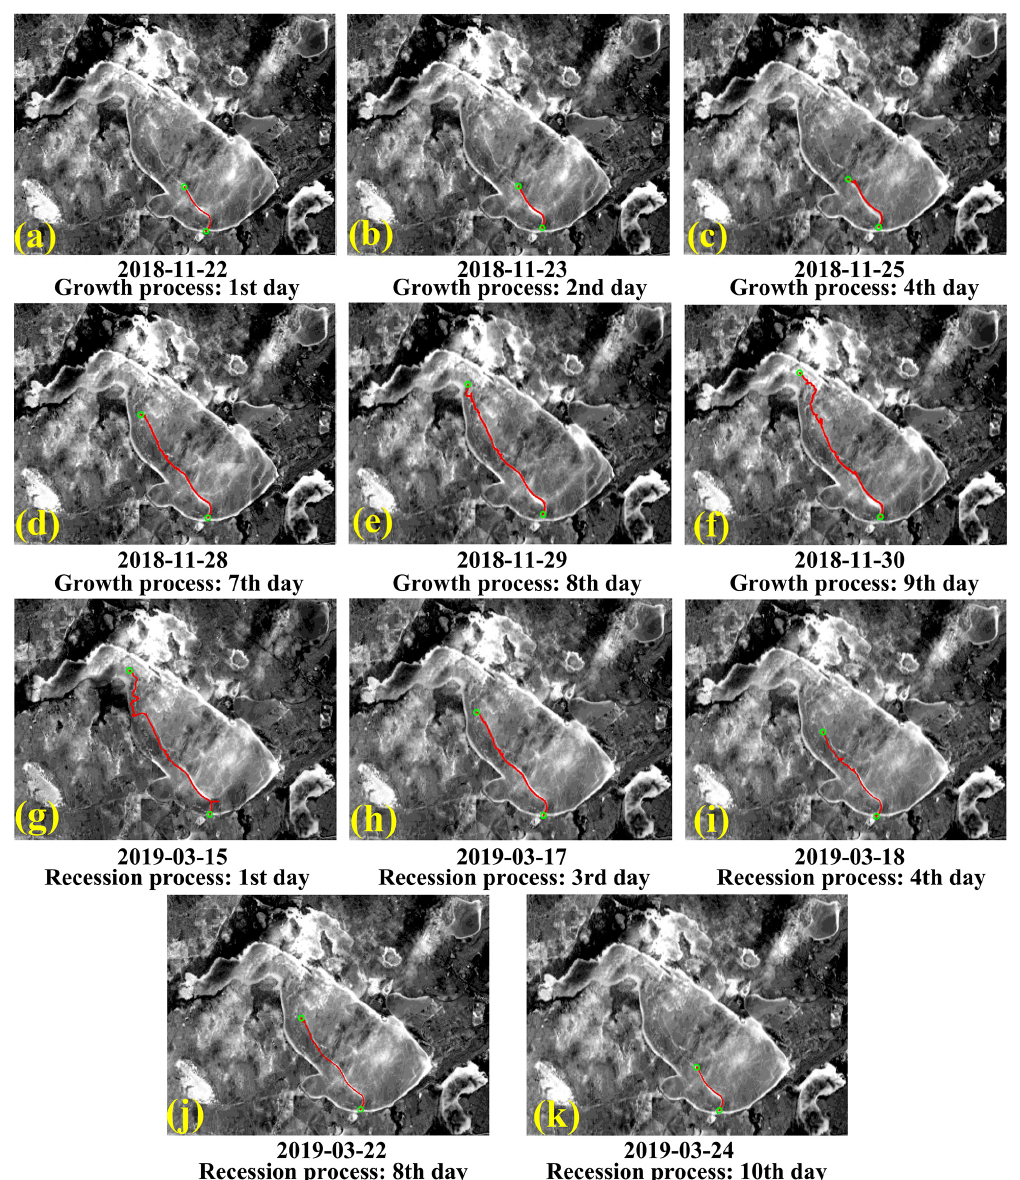
Figure 5. The spatiotemporal changes in the linear structure for the fusion images of Lake Chagan during the cold season of 2018–2019.